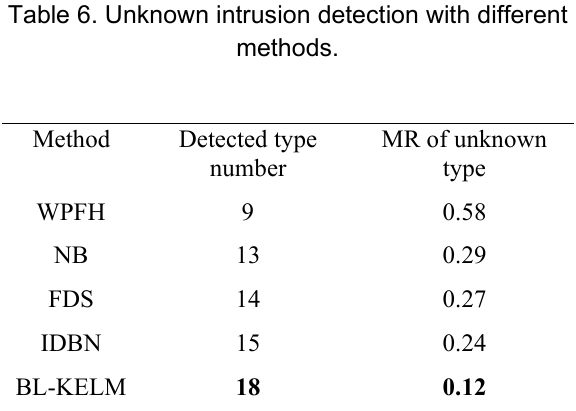
Table 5. Running time comparison Method